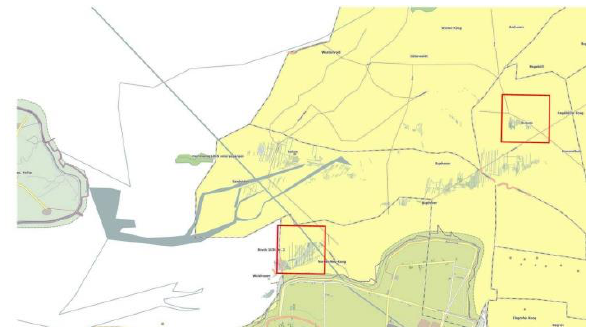
Figure 3. Map showing locations of residuals of former landuse, in the region of interest. Inserted are two red squares that denote the locations of the SAR image details shown in Figure 6 and in Figure 8, respectively. Map: C. Kost.